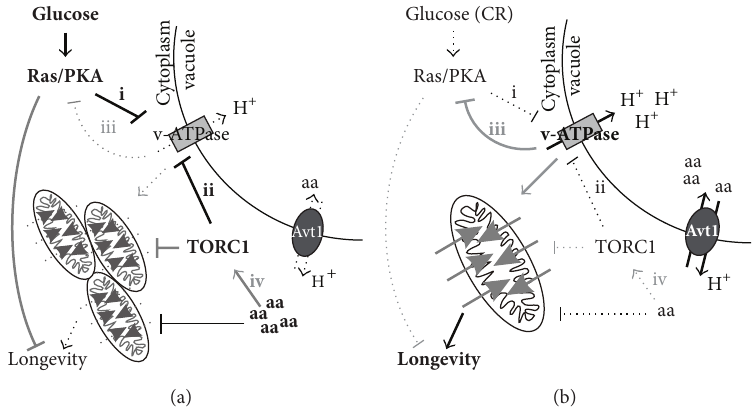
Figure 2: Model for how CR postpones mitochondrial deficiency and aging via stimulating the function of vacuolar ATPase (v-ATPase) and the import of neutral amino acids into the vacuolar lumen. (a) Upon high glucose levels increased Ras-cAMP-PKA (Ras/PKA) activity inhibits v-ATPase function (arrow i) and thereby also the neutral aminoacid transporter Avt1 leading to the accumulation of neutral amino acids in the cytoplasm. Among these, leucine has been proposed to activate TORC1 through the leucyl-tRNA synthetase LeuRS and the Gtr1 GTPase (arrow iv). Cytosolic amino acid accumulation is thought to decrease mitochondrial function and to stimulate aging, possibly via increased TORC1 signaling. Increased TORC1 activity would also be expected to further inhibit v-ATPase function (arrow ii). Reduced v-ATPase function might also be expected to releive v-ATPase inhibition of Ras-PKA via cytosolic alkalinization (arrow iii). (b) CR and reduced glucose inhibition of v-ATPase function by Ras-PKA (arrow i) stimulates Avt1-mediated uptake of neutral amino acids. Lower cytoplasmic leucine levels would be expected to reduce TORC1 activity (arrow iv) and TORC1-mediated repression of v-ATPase activity (arrow ii). Similarly, increased v-ATPase function might be hypothesized to increase the inhibition of Ras-PKA activity, possibly via cytosolic acidification. Mitochondrial functions are maintained under conditions of reduced Ras/PKA and TORC1 activity as well as reduced levels cytosolic amino acids, which stimulates longevity. Arrows in black represent mechanisms at least in part experimentally verified to be in operation in aging cells [11] whereas arrows in grey indicate mechanisms inferred based on recent data implicating cytosolic pH and v-ATPase in the regulation of Ras-PKA [14, 16] as well as cytoplasmic leucine levels in the regulation of TORC1 signaling